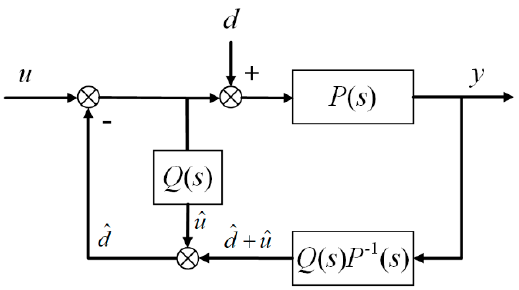
Figure 23. The basic control structure of a disturbance observer.